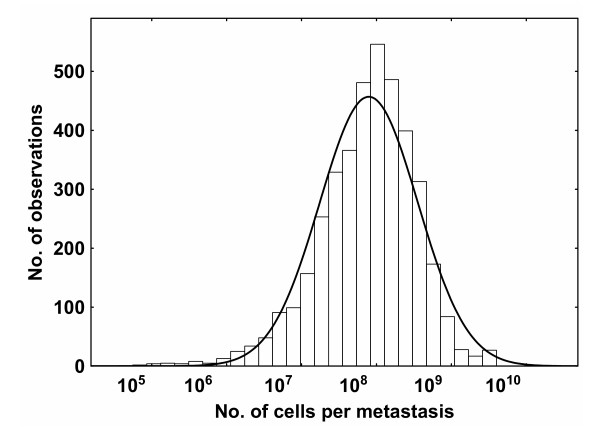
Size distribution for metastases. A model for the growth of metastases was based upon a stochastic birth process where the growth times of the individual colonies were normally distributed. Four thousand simulations were performed. The resultant frequency histogram for the logarithm of the number of cells per metastasis is shown here, and it approximated a normal distribution (solid line). This was equivalent to a lognormal distribution for the sizes of metastases.